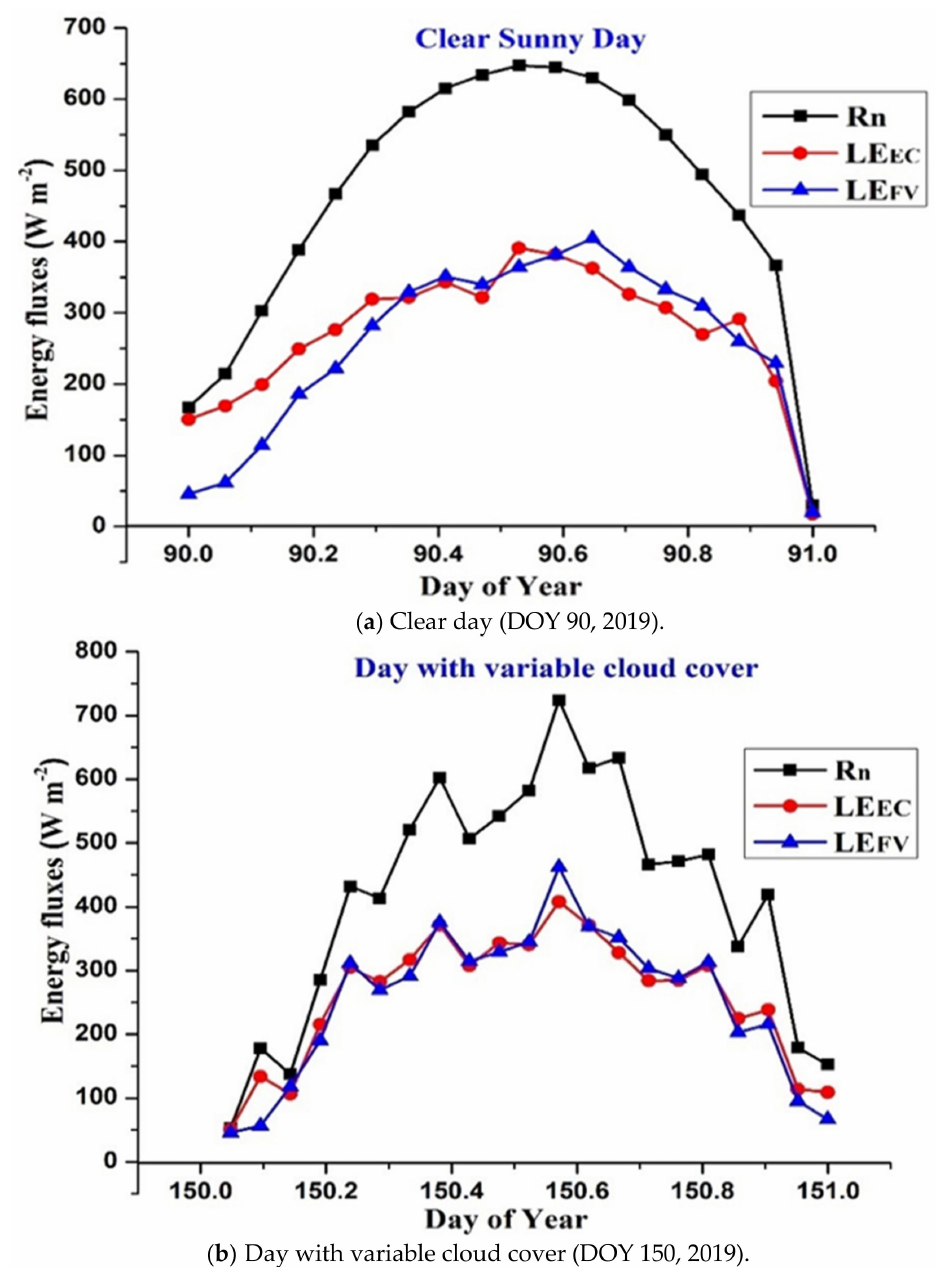
Figure 9. Diurnal variations in the LE EC and LE FV , along with the net radiation, for two different days: ( a ) clear day (DOY 90, 2019); ( b ) day with variable cloud cover (DOY 150,